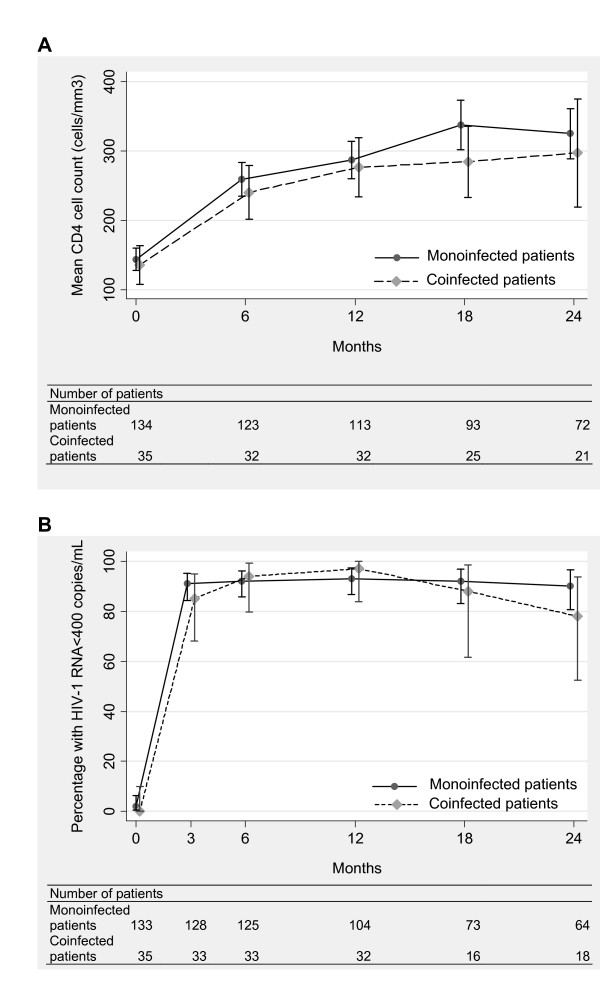
Immunological and virological responses to antiretroviral therapy by infection group: mean CD4 cell count (A), and percentage of patients with plasma HIV-1 viral load below 400 copies/mL (B). Bars indicate 95% confidence intervals.